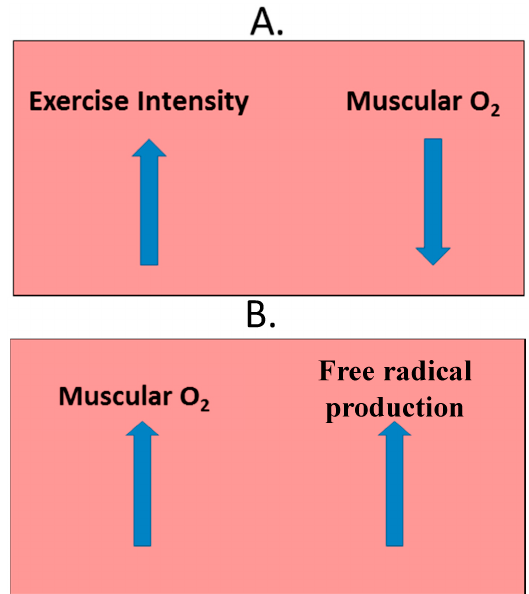
Figure 2. Skeletal muscle during ( A ) and after ( B ) exercise. ( A ) during exercise, as intensity reaches the point of VO 2max (maximum volume of oxygen uptake) muscular oxygen is depleted; ( B ) after exercise, muscular oxygen is repleted at such a fast pace potentially-damaging free radicals are produced [71,72].